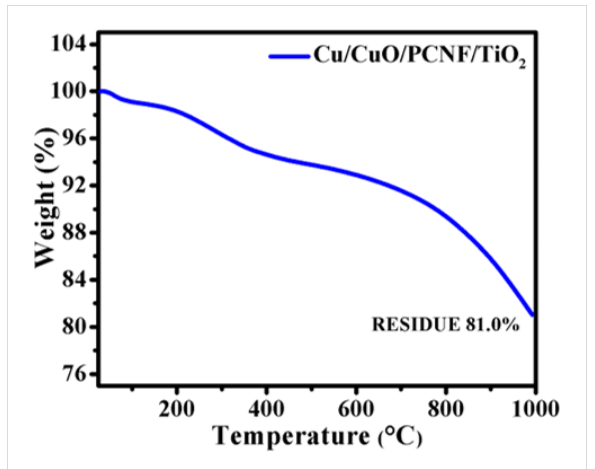
composite was found to be 71.879 m 2 g − 1 . Pores with a mean diameter of ≈ 12–15 nm were determined by the Barrett–Joyner–Halenda (BJH) method (Figure 7b).